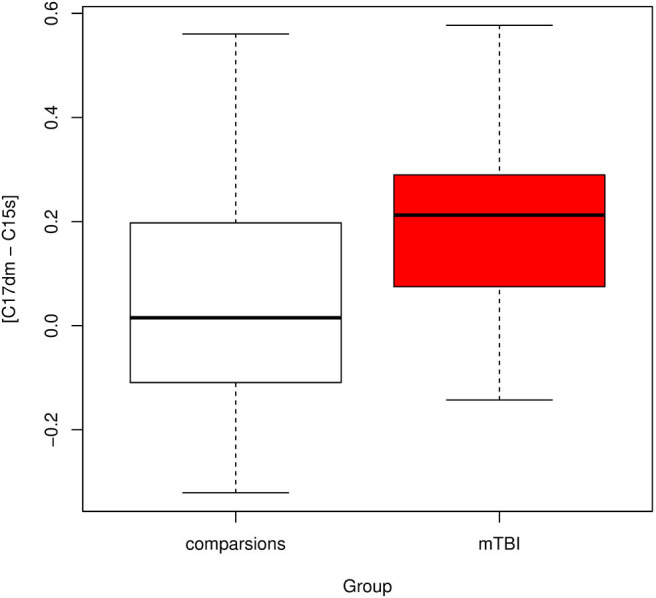
Boxplot of connectivity between components 17 and 15 [C17dm – C15s]. C17dm is in the default mode network and C15s is in the salience network.